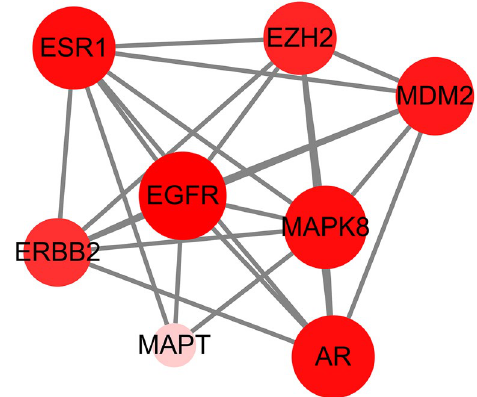
Figure 4. Core targets. This figure shows the core target map obtained based on 42 common targets constructed by PPI, based on topological heterogeneity analysis and setting twofold average node degree. Among them, EGFR and MAPK targets have the most interactions with other targets among the core targets, and thus they play a crucial role in the treatment of